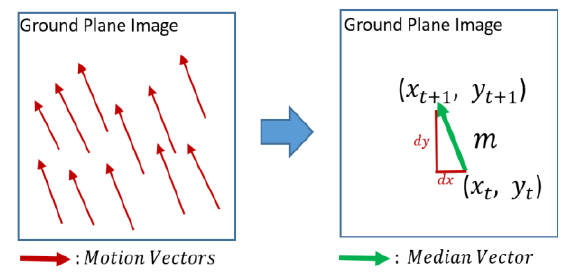
Figure 7 . The motion vectors on the Ground Plane Image.